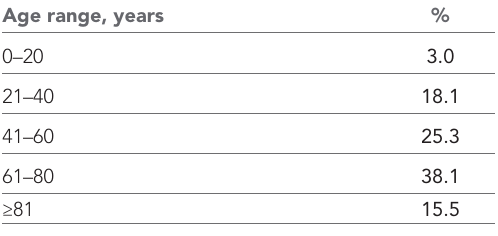
Table 1 Age distribution of the 503 patients